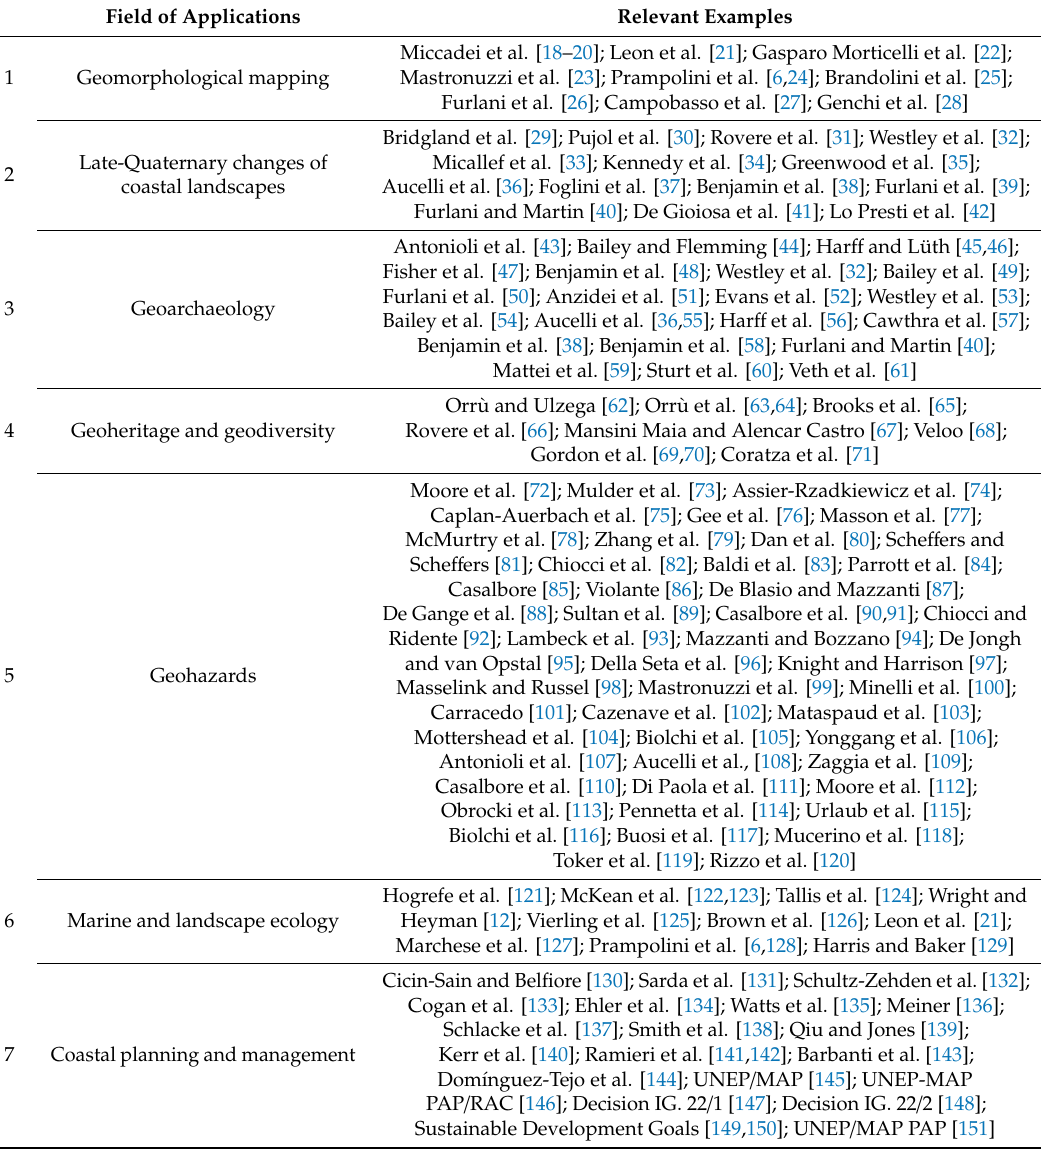
Table 1. Outline of the most relevant scientific literature showing the outputs of integrated terrestrial and marine research with reference to the ‘seven good reasons’ mentioned